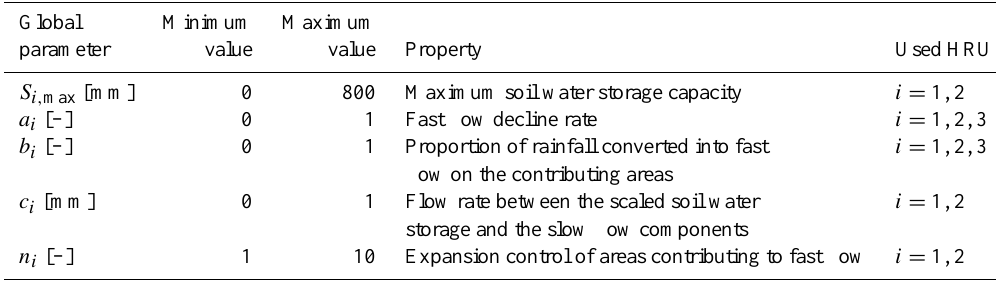
Table 1. Parameters of the hydrological response units (HRU i = 1, 2, 3) that need to be determined during calibration (adopted from Table 2 in Lazzarotto et al., 2006). HRU 1 = well drained, HRU 2 = poorly drained, HRU 3 = urban.